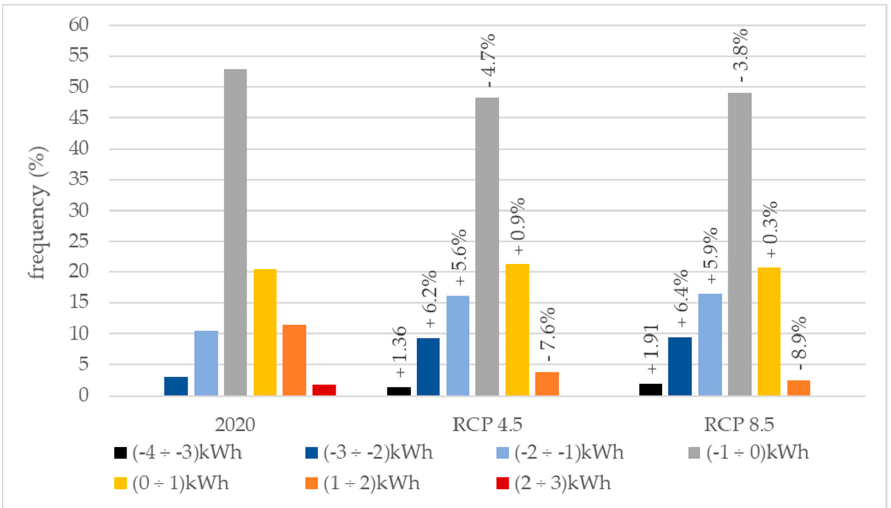
Figure 3. Frequency distribution of energy needs for heating and cooling. Negative ranges refer to cooling, positive to heating.